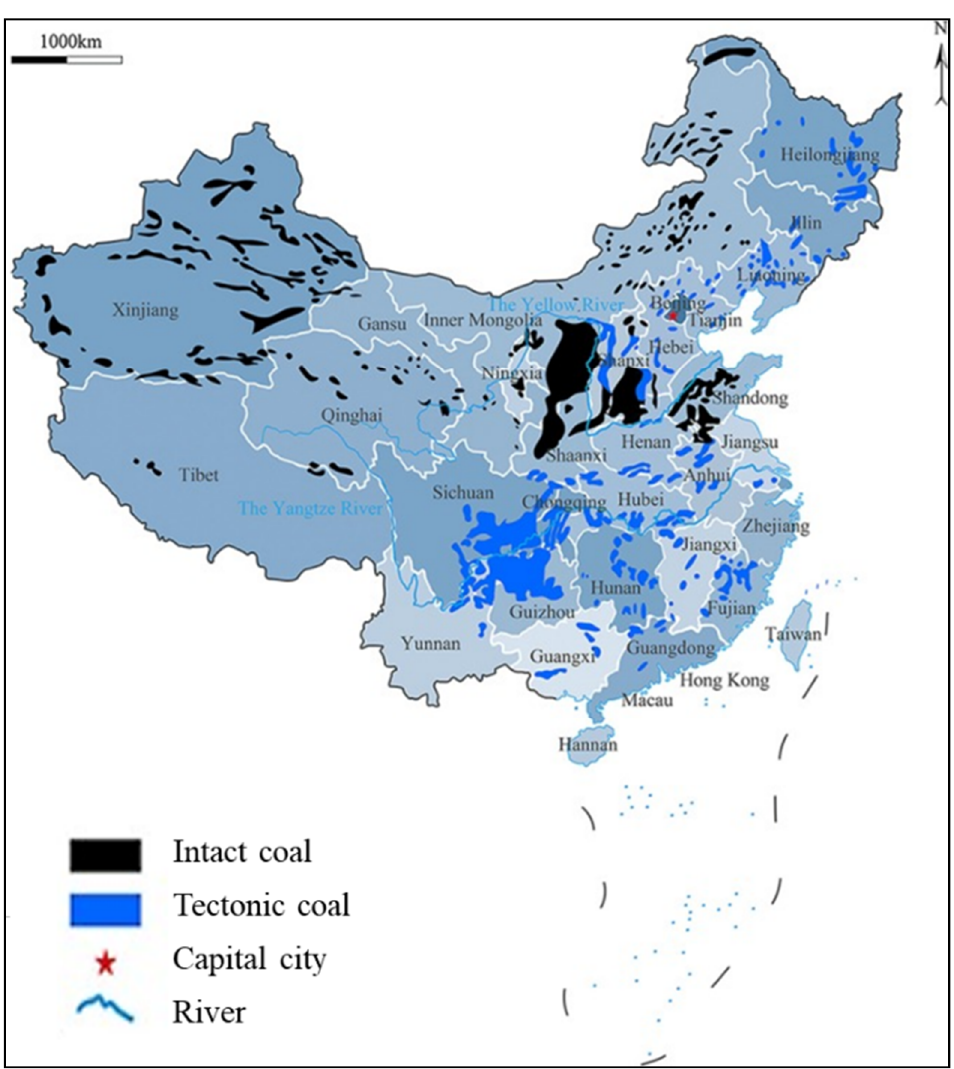
Figure 1. Possibility distribution of tectonic coal in China (from Cheng et al. [3]).